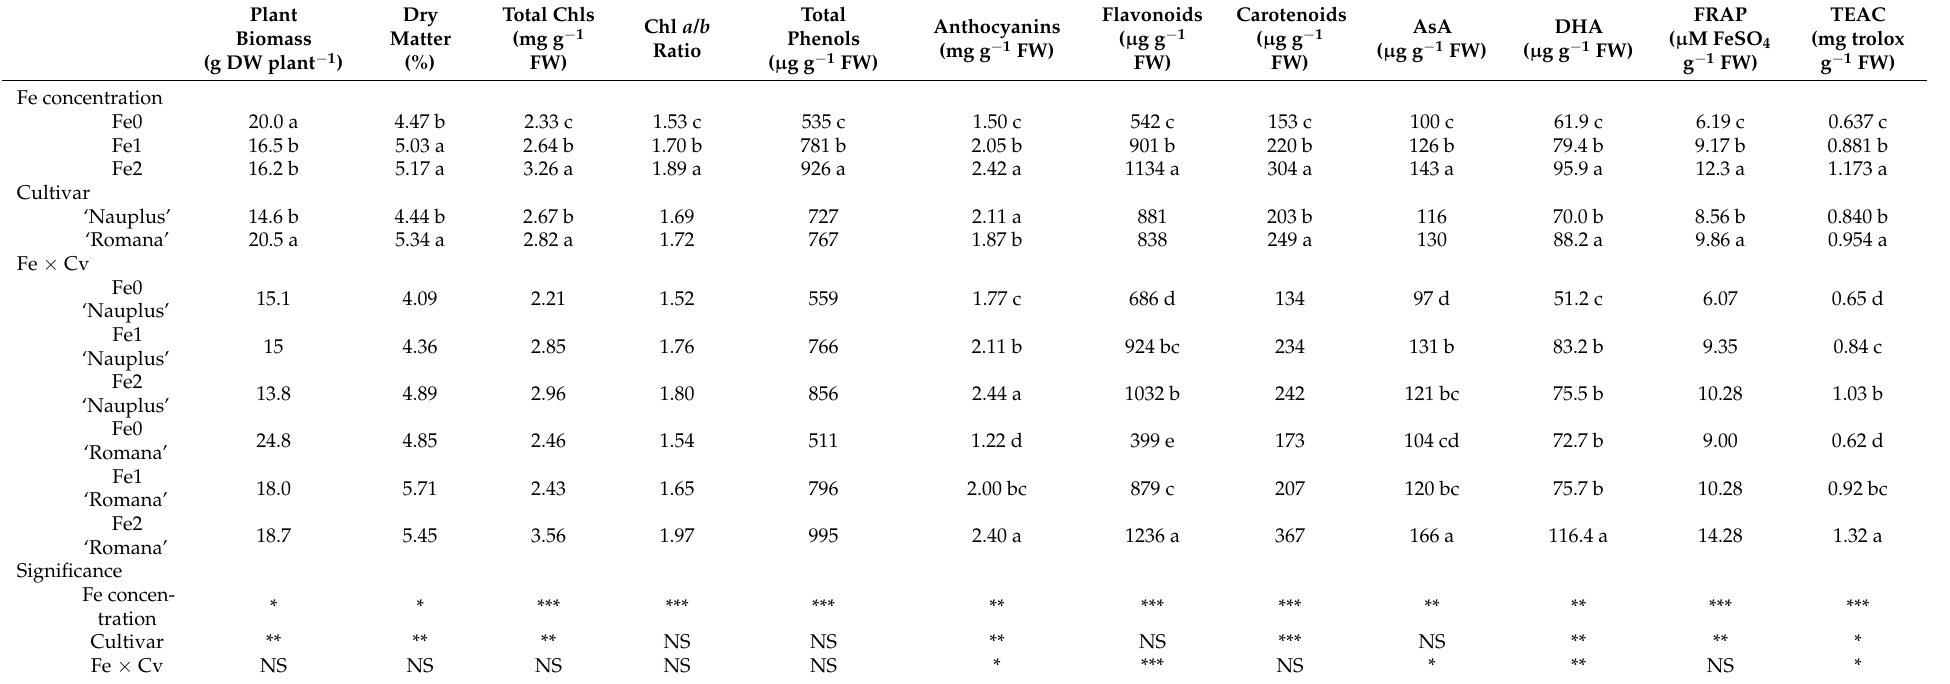
Table 1. Lettuce main traits and bioactive compound concentrations as affected by the studied